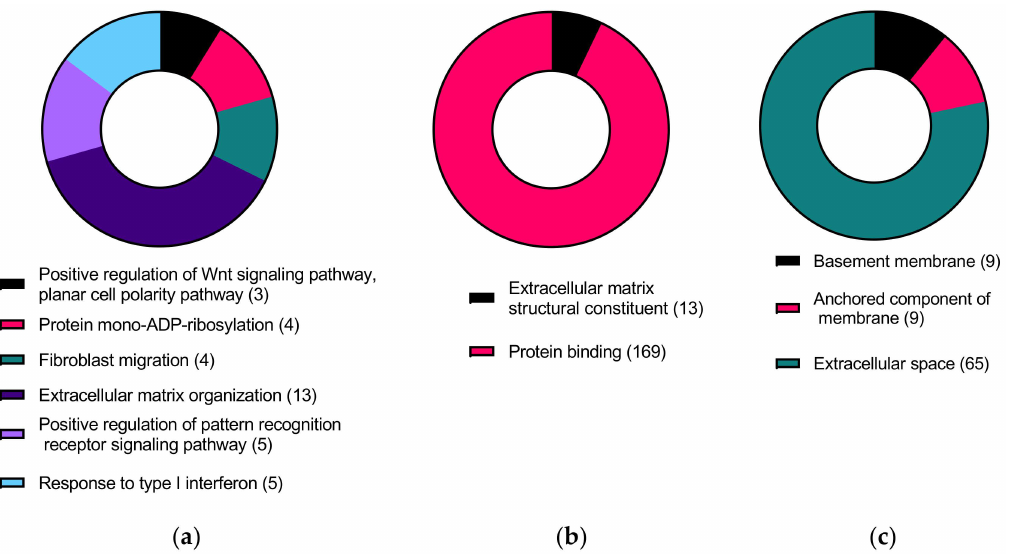
Figure 5. Gene ontology terms showing ( a ) biological processes, ( b ) molecular functions, and ( c ) cellular components of significant differentially expressed genes in KC-altered genes responsive to TGF β 1 treatment (FDR ≤ 0.05). Numbers in brackets are the number of genes involved in each process.